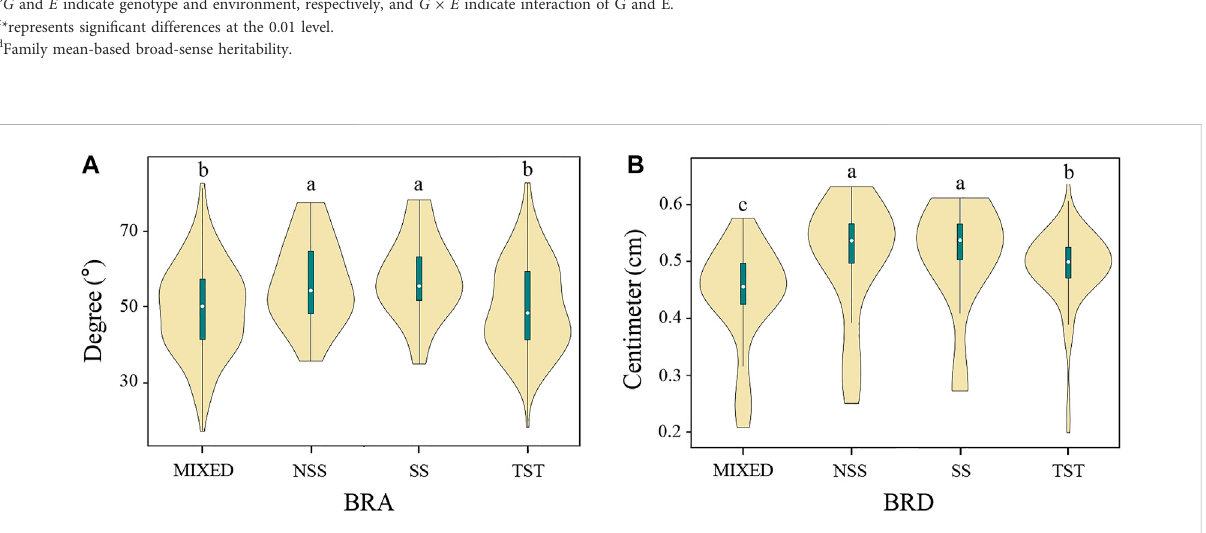
(Table 2; Supplementary Table S3).